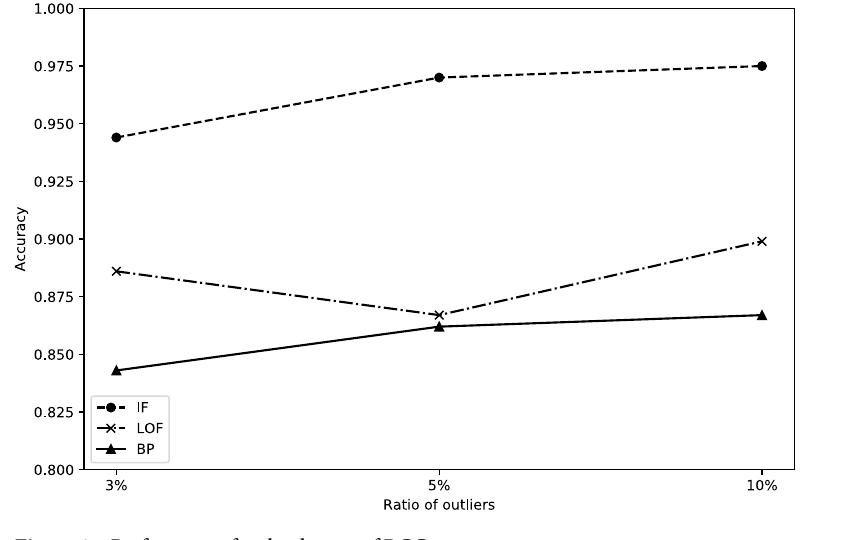
Figure 2. Performance for the dataset of